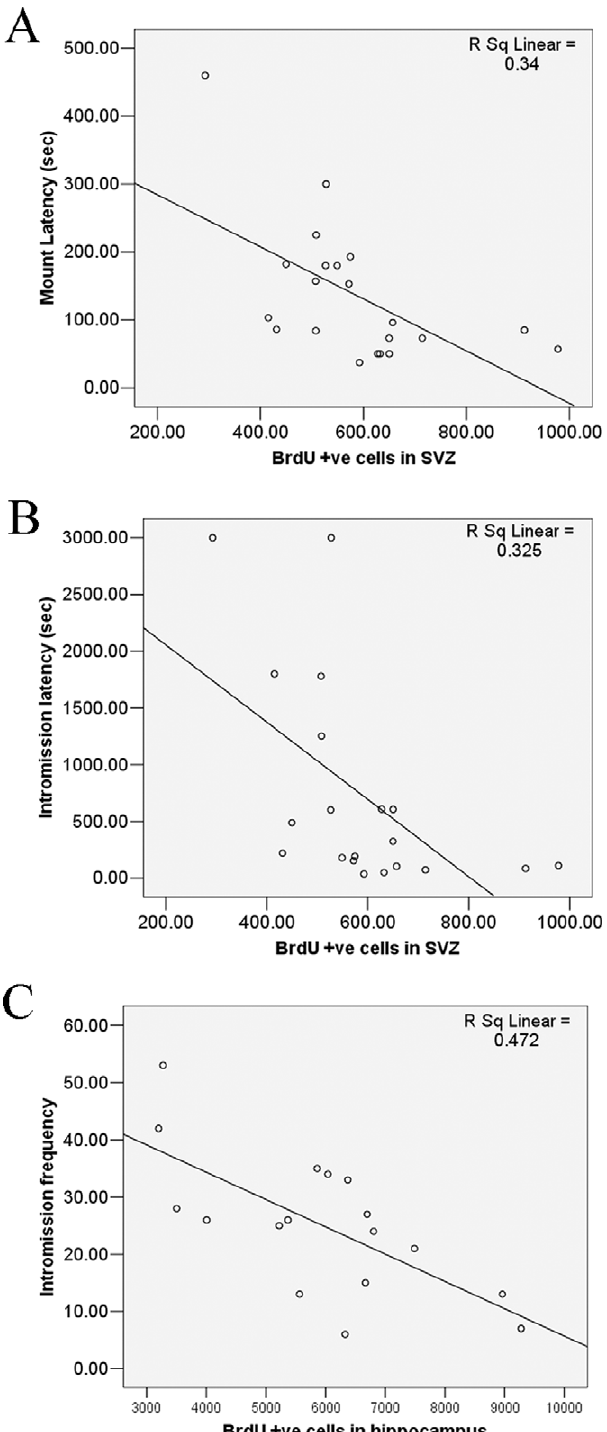
Figure 6. Linear regression of ML and BrdU-positive cells in SVZ ( A ) , IL and BrdU-positive cells in SVZ ( B ) and IF and BrdU- positive cells in hippocampus ( C ) in rats treated with PBS, corticosterone or both corticosterone and LBP for 21 days.